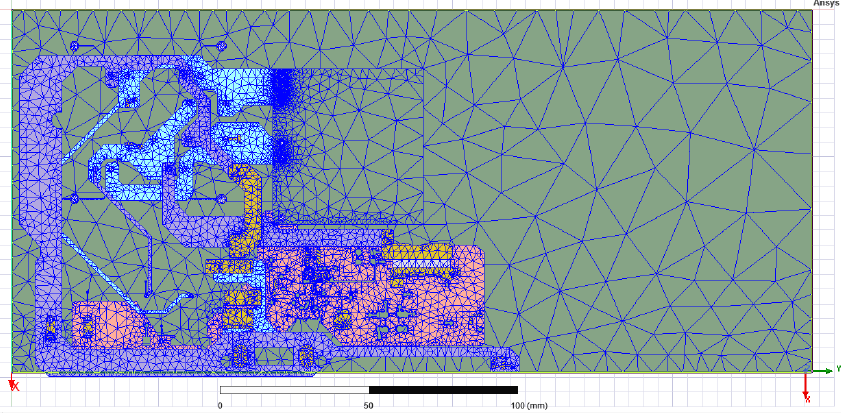
Figure 16. Overview of the ports assigned to the 3D model in HFSS.